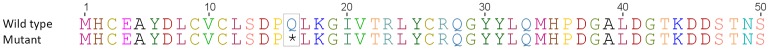
Protein sequence alignment of fibroblast growth factor 14.Protein sequence alignment of wild type and mutant ovine fibroblast growth factor 14, highlighting the Q16X mutation which induces a stop codon. The Q16X mutation was determined after whole genome sequencing using Illumina HiSeq 2000 machine, aligning to the reference sheep genome (Oar3.1) using BWA-MEM, calling variants with GATK 3.4–46, and predicting variant effects with SnpEff 4.1.